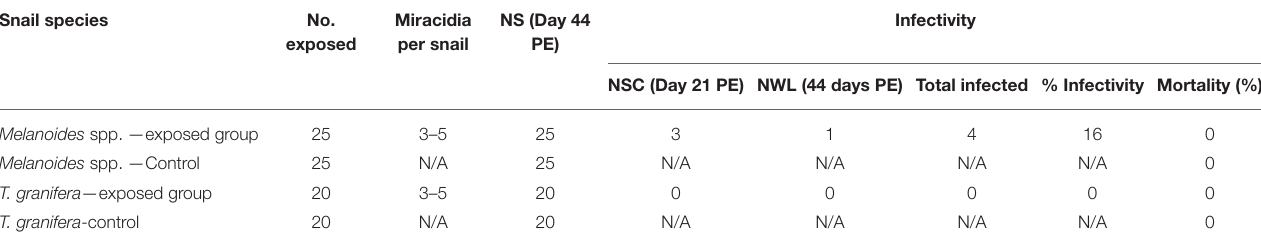
TABLE 1 | Summary of infection and mortality rates of Melanoides sp. and Tarebia granifera exposed to Calicophoron microbothrium miracidia. Snail species No.